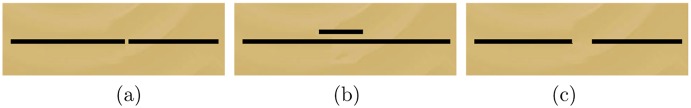
(a) The inpainted image when the first phase uses C(p) and the second phase uses D(p) (first phase executes 120 steps); (b) The inpainted image when the first phase uses C(p)D(p) and the second phase uses D(p) (first phase executes 120 steps); (c) The inpainted image when the priority is determined only by confidence term C(p).